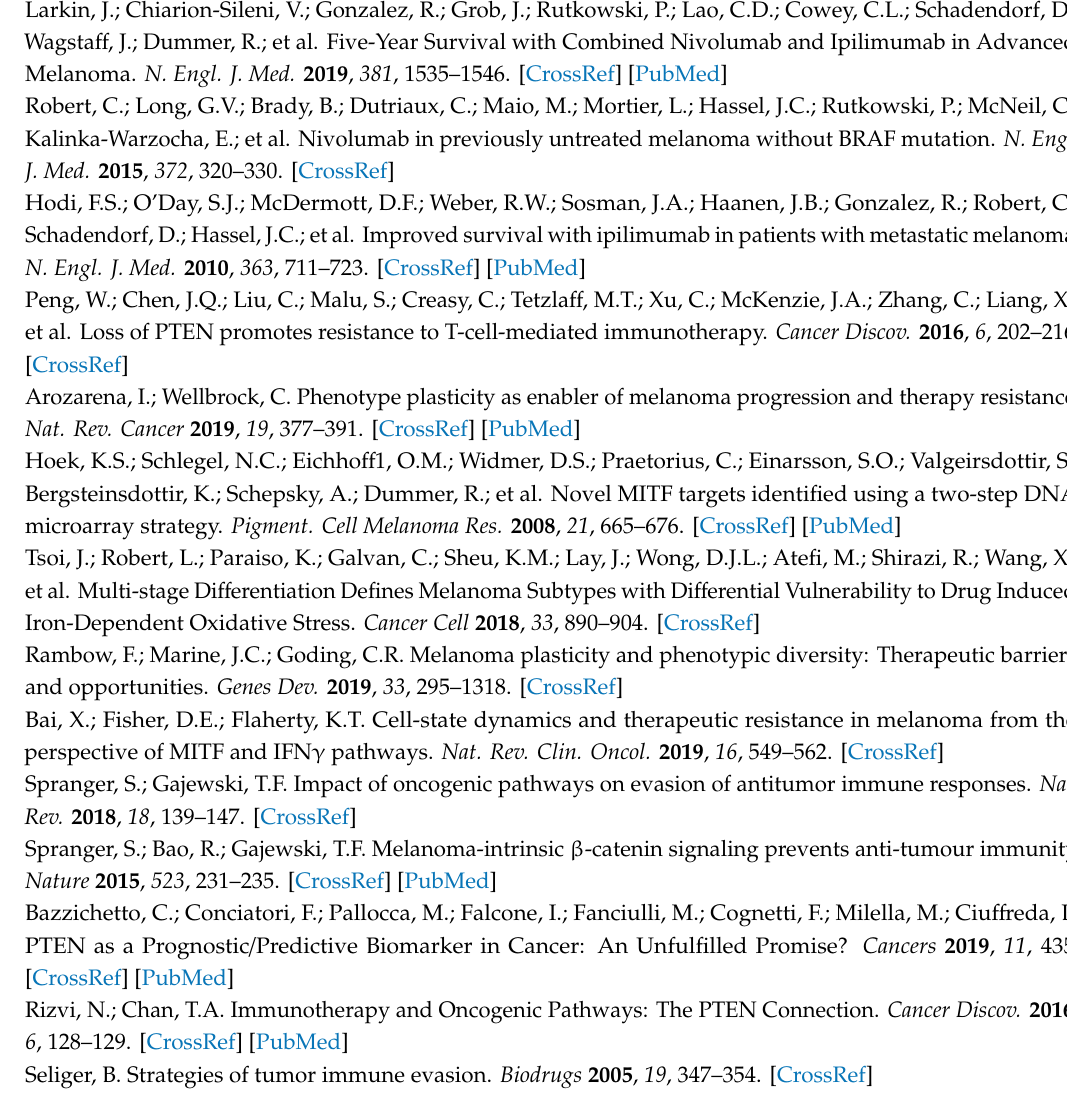
Figure S1: MCP immune scores in melanoma tumors, Figure S2: Flowchart of di ff erent data levels included in the study, Figure S3: PTEN staining in the five tissue microarray (TMA) blocks, Table S1: Multivariate cox regression model analysis of MITF / PTEN groupings adjusted for stage of disease, with hazards ratios and confidence intervals, Table S2: Centroid used in the